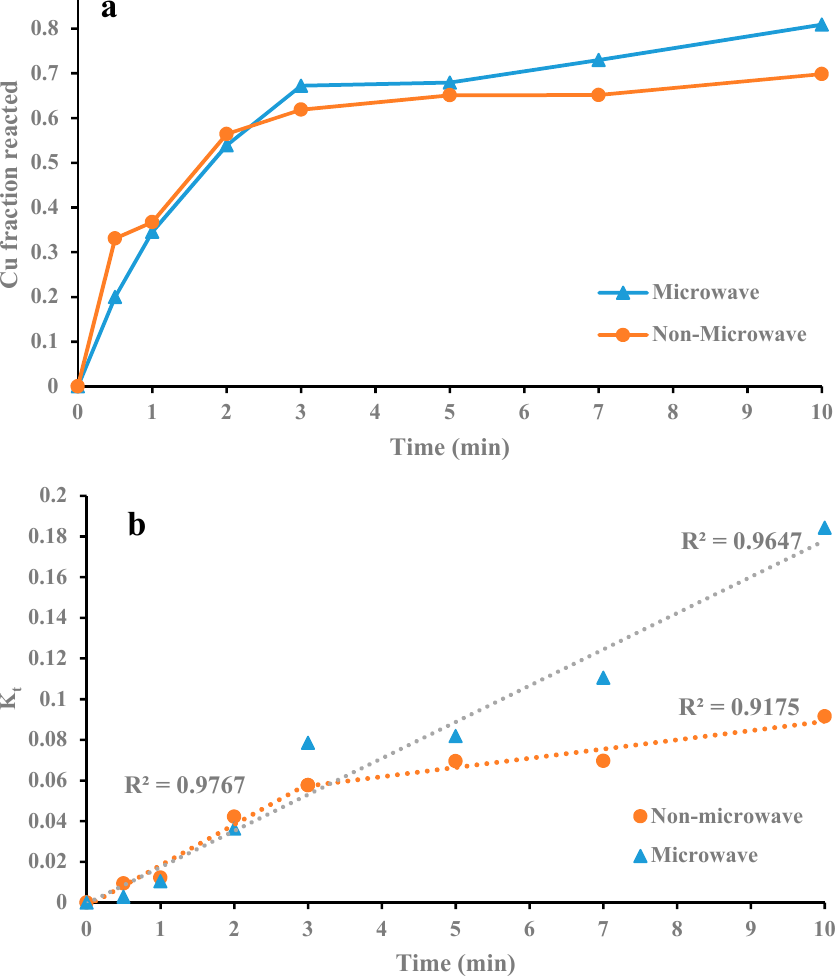
Figure 9. Leaching agent temperature fluctuation during microwave irradiation with 1000 W power.